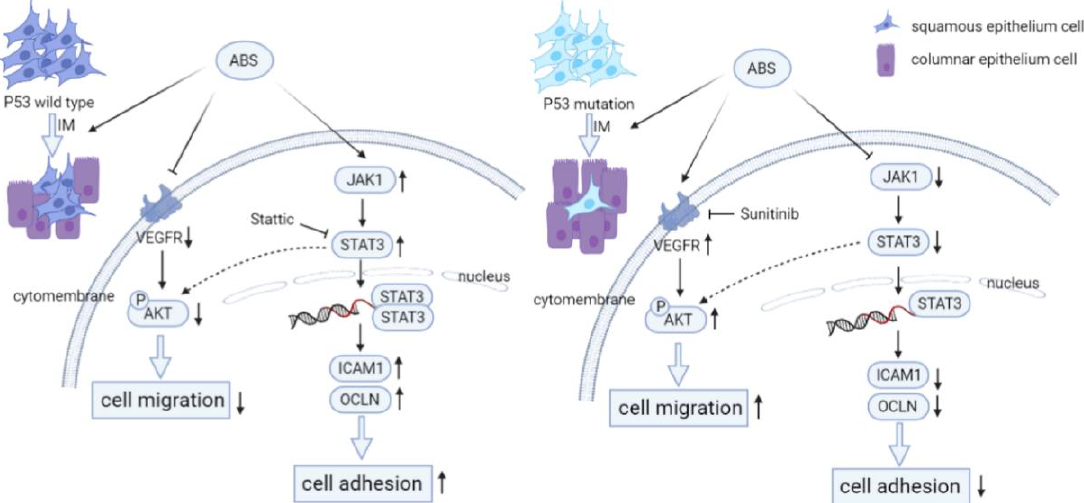
Figure 7. P53 deficiency promotes esophageal epithelium intestinal metaplasia malignancy after exposure to Acid Bile Salt. ( Left ) In P53 wild-type esophageal epithelial cells, ABS stimulation induces intestinal metaplasia of the esophageal epithelium and reduce the invasive ability of HET1A cells by downregulating the expression level of VEGFR and inhibiting the phosphorylation modification of AKT . Meanwhile, the JAT/STAT pathway is activated, and the downstream cells’ adhesion-related proteins ( ICAM1, OCLN, CLDN2 ) are highly expressed, resulting in the enhancement of cell adhesion ability. ( Right ) Compared with wild-type esophageal epithelial cells, P53 deficiency promotes ABS-induced intestinal metaplasia of the esophageal epithelium. And the expression level of VEGFR and the phosphorylation of AKT are upregulated to enhance the invasive ability of HET1A cells. However, JAK/STAT pathway is inhibited, and the downstream cell adhesion-related proteins are repressed, reducing cell adhesion ability.